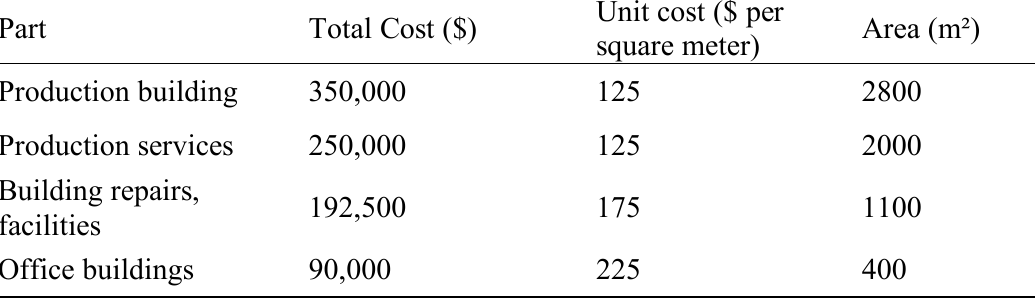
Table 4. Construction and construction